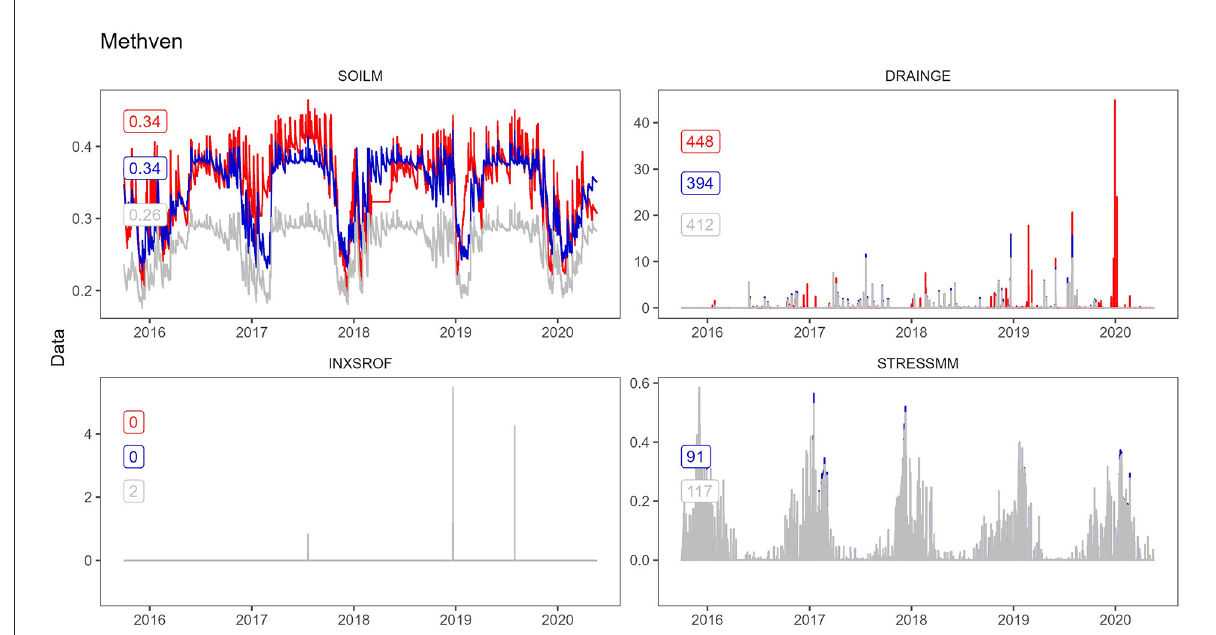
FIGURE6 Model output after calibration to Methven data. Red, blue and gray traces indicate the data, calibration and upscaled prediction, respectively. Colored numbers indicate annual averages or totals. Units: SOILM (m 3 /m 3 ), DRAINGE (m/d), INXSROF (mm/d) and STRESSMM (m 3 /m 3 ).